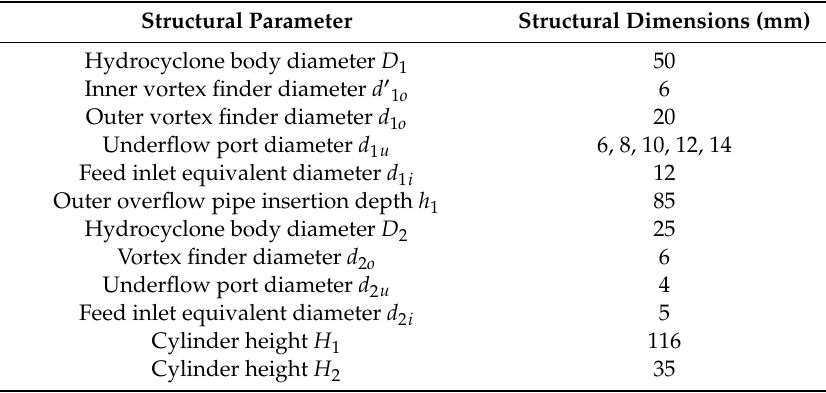
Table 1. Specifications of the hydrocyclone used in this study.